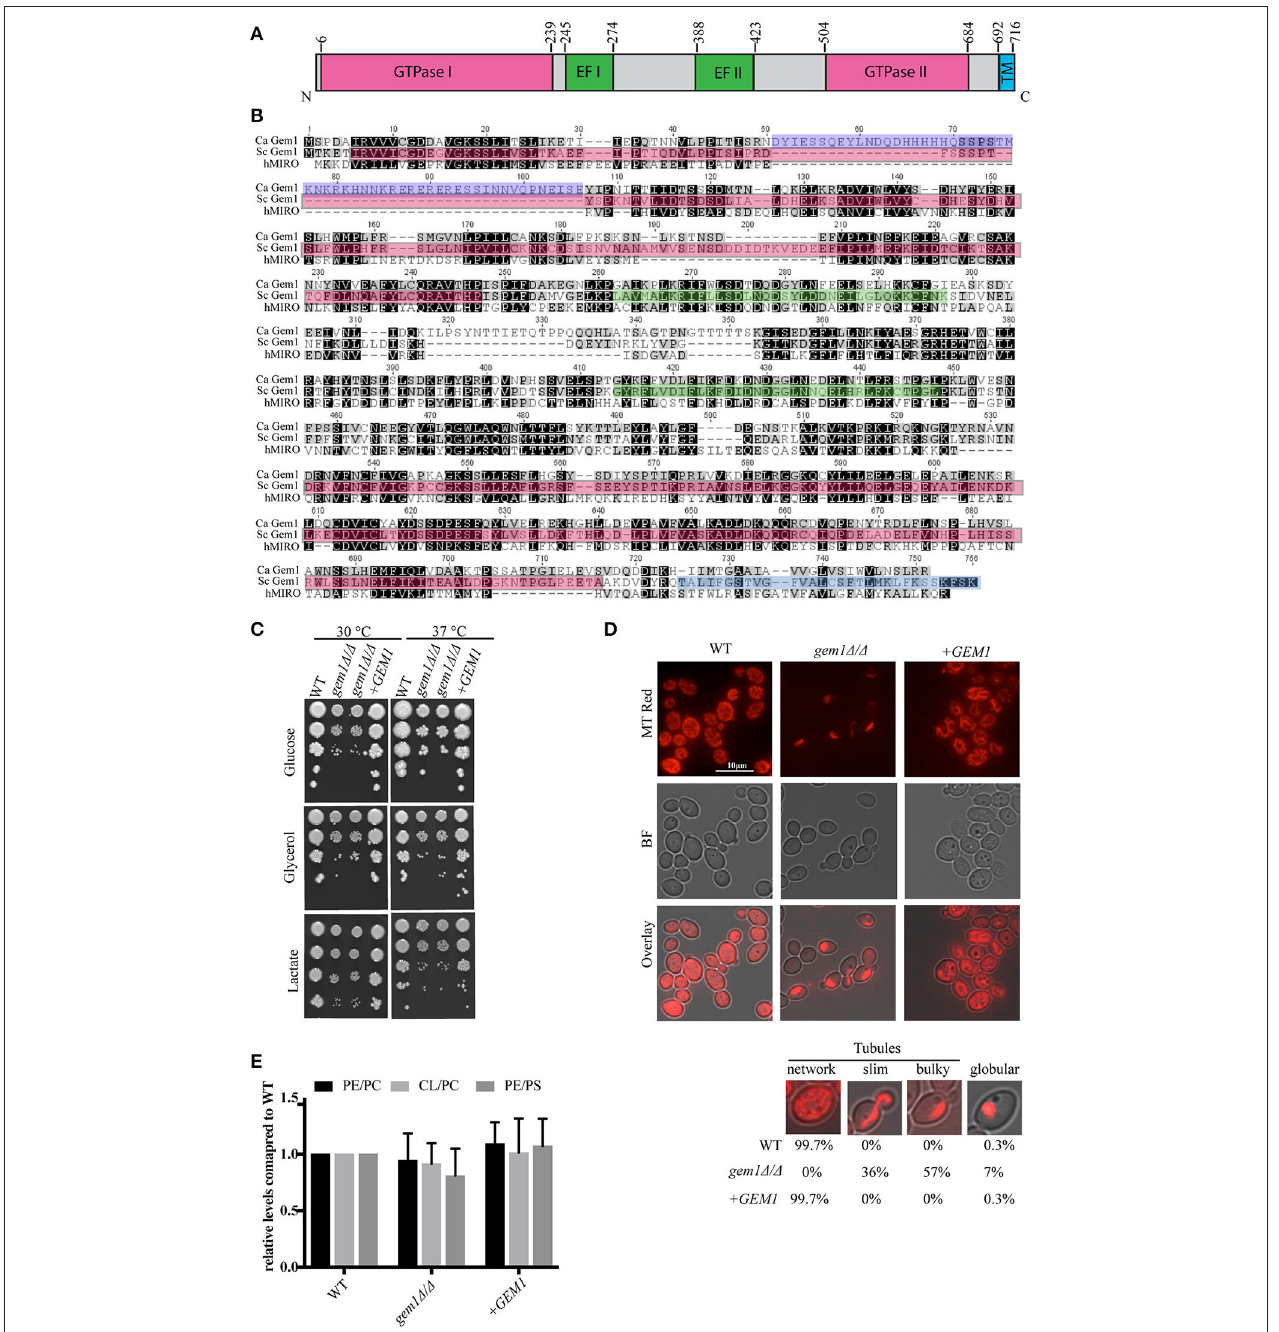
FIGURE 1 | The dominant cellular function of C. albicans Gem1 is to maintain tubular mitochondrial morphology. (A) Domain structure of C. albicans Gem1. TM, Transmembrane domain; EF, Ca2 + binding EF hand domain. (B) Protein sequence alignment of Gem1 from C. albicans, S. cerevisiae , and their human ortholog MIRO1 (hMIRO). The colored regions represent the following: Red, GTPase I and II; violet, 56 amino acids not present in hMIRO or Sc Gem1; green, Ca 2 + binding domain EF I and II; blue, transmembrane domain. The alignment was performed with MUSCLE MUltiple Sequence Comparison by Log-Expectation v3.8.31. (C) Growth of C. albicans wild type, two independent gem1 1 / 1 mutants and the complemented + GEM1 strains on plates containing glucose, glycerol or lactate as the carbon source. Ten-fold serial dilutions were spotted, and plates and were photographed after 2 days of growth at the indicated temperatures. (D) Mitochondrial morphology was assessed after staining of cells with MitoTracker Red. MT, MitoTracker; BF, Bright field. The brightness of the fluorescent pictures was increased by 20% to create the overlay pictures. Mitochondrial phenotypes were quantified according to their appearance, assessing 600 cells per strain. (E) Phospholipids were separated by one-dimensional TLC and quantified as described in section Materials and Methods. A representative TLC is shown in Figure S2 . PS, phosphatidylserine; PE, phosphatidylethanolamine; CL, cardiolipin; PC, phosphatidylcholine. Shown are the mean and standard deviation from three biological